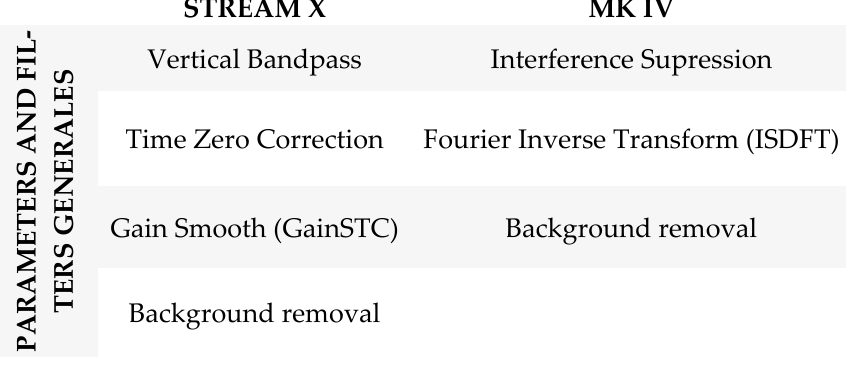
Figure 4. Filter packages applied to both GPR equipment.